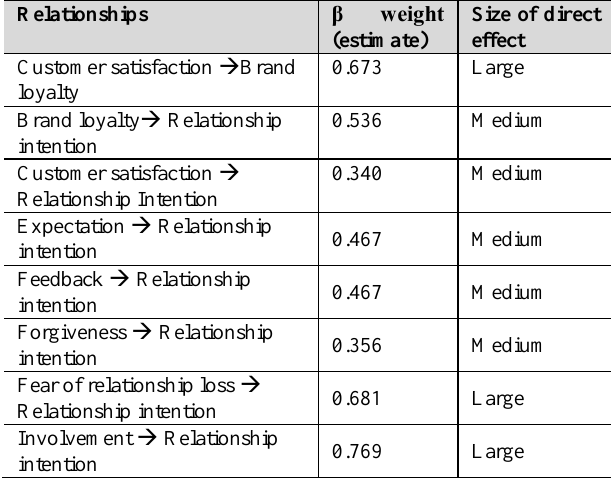
Table 4: Standardised regression weights of the structural